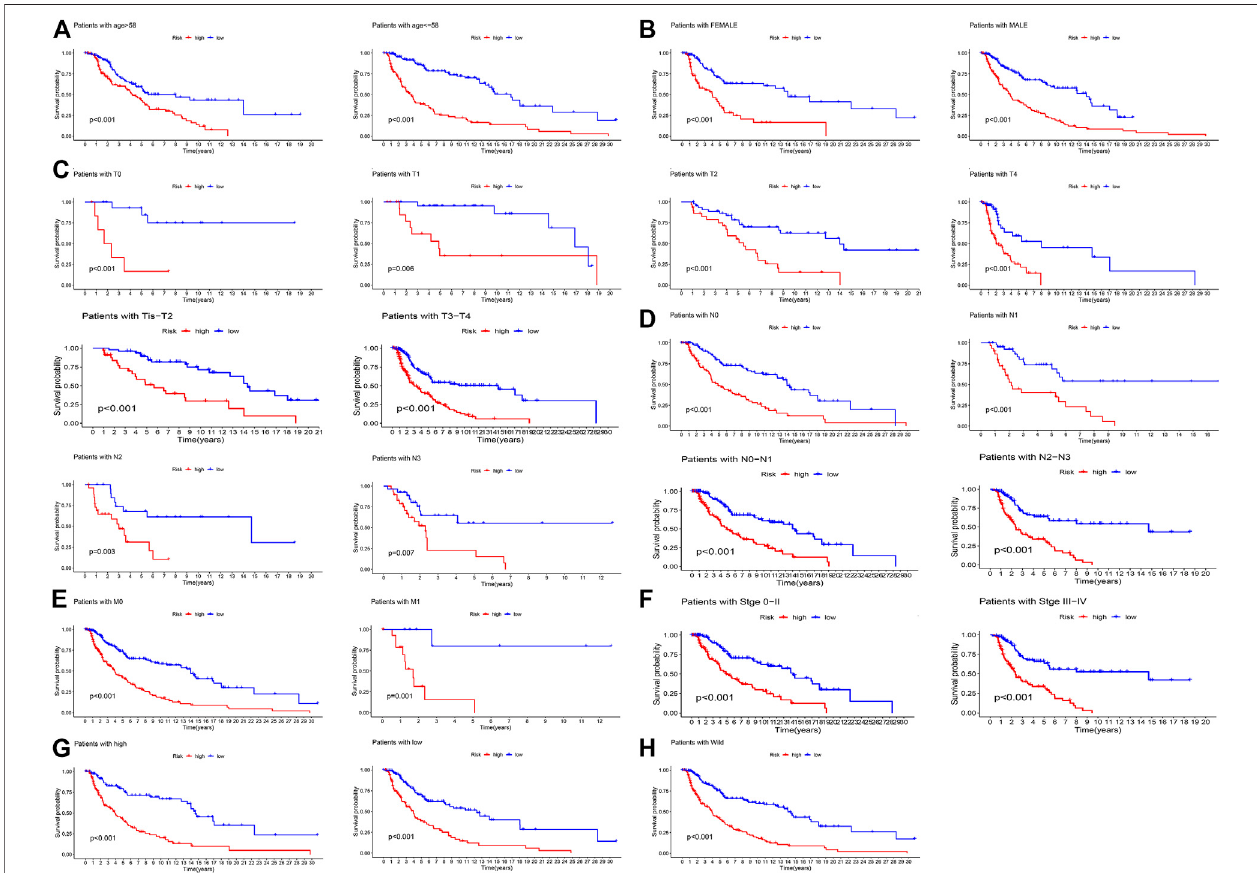
FIGURE 6 | The K-M survival analyses of patients ’ clinicopathological strati fi cation between the high- and low-risk groups. (A) Patients > 58 or ≤ 58 years; (B) patients were female or male patients; (C) patients with pathologic T0, T1, T2, T4, Tis-T2, and T3-T4 stages; (D) patients with pathologic N0, N1, N2, N3, N0 – N1, and N2 – N3stages; (E) patientswithpathologicM0orM1stage; (F) patientswithtumor0 – IIorIII – IVstage; (G) patientswithhighorlowexpressionofTP53; (H) patientswith TP53 wild-type.